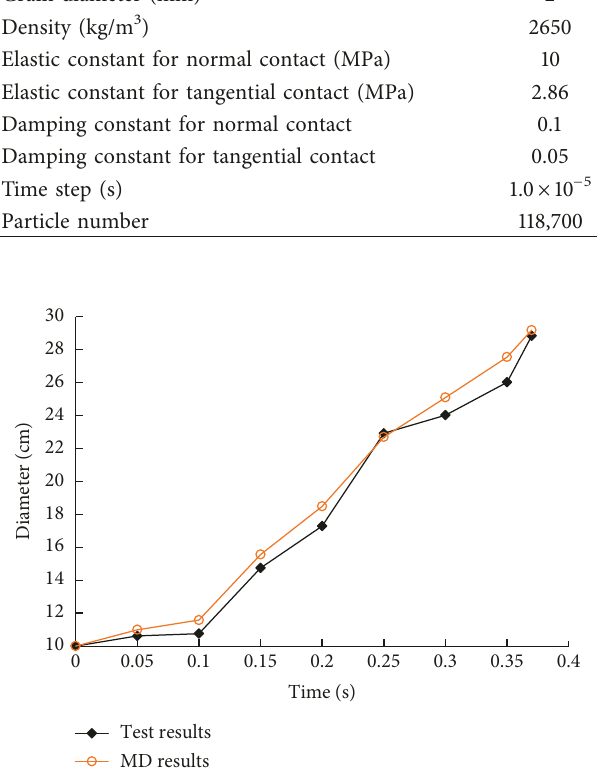
Figure 6: The change of the diameter of the cone bottom with time in MD simulation.